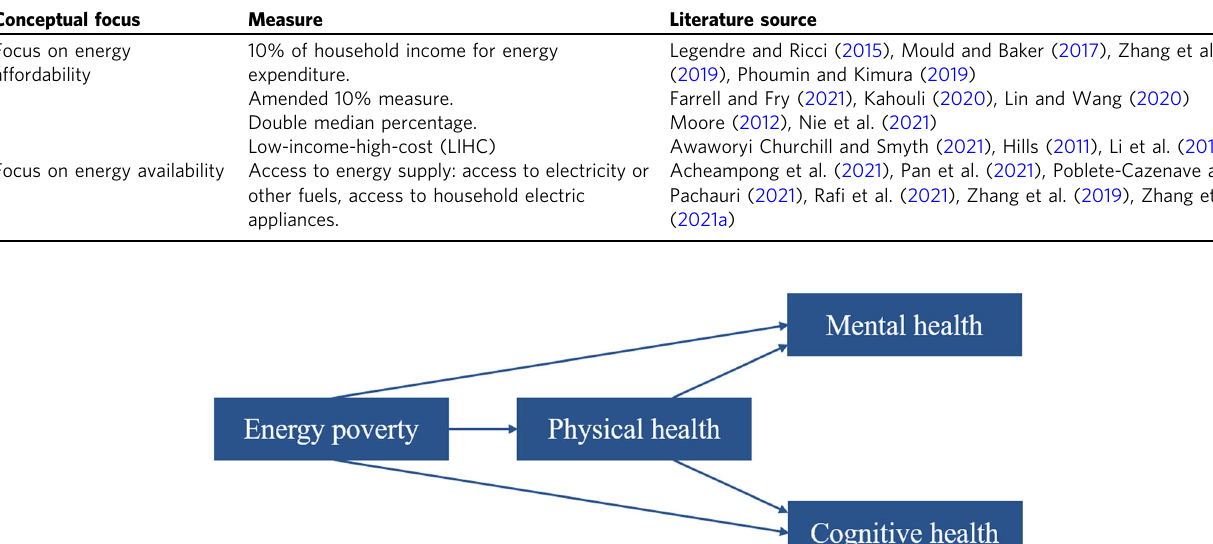
Table 1 Literature related to EPOV measures.